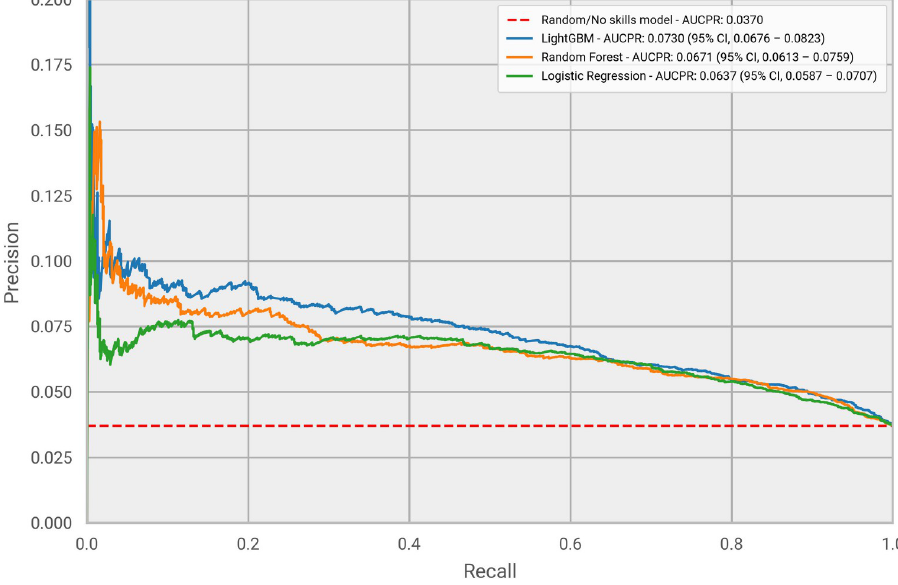
Fig 4. PR curves. Performance evaluation of the three machine learning models, measured using a Precision Recall